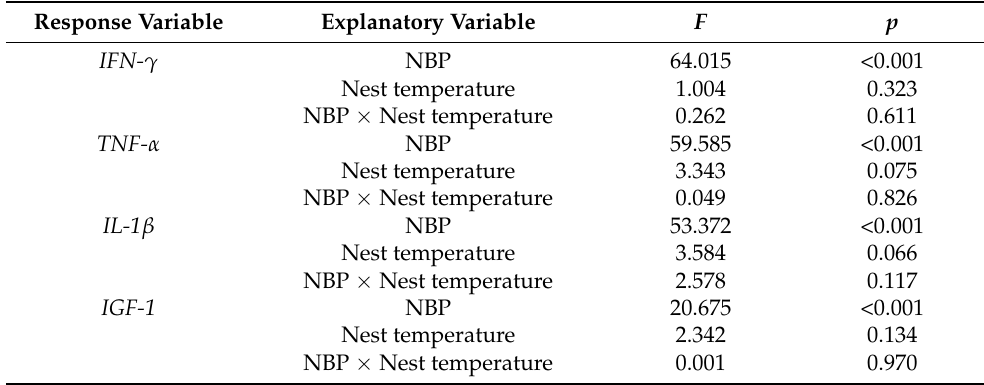
Table 2. Results of linear mixed models of the effects of nymph biomass proportion (NBP) and nest temperature on the expression of the interferon γ ( IFN- γ ), tumor necrosis factor- α ( TNF- α ), interleukin-1 β ( IL-1 β ) genes and the plasma insulin-like growth factor-1 (IGF-1) of Asian short-toed lark ( Alaudala cheleensis ) nestlings. NBP is the proportion of the daily grasshopper nymph biomass relative to the total biomass measured on all survey days.